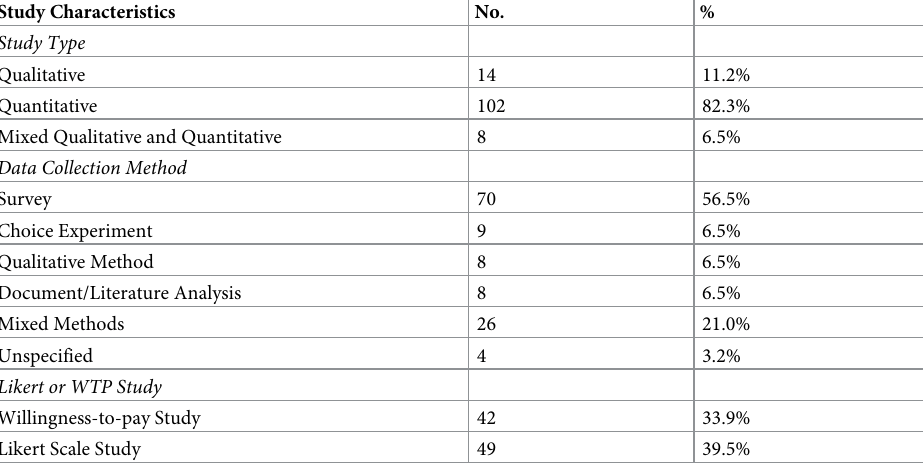
Table 3. Methods used in the extracted